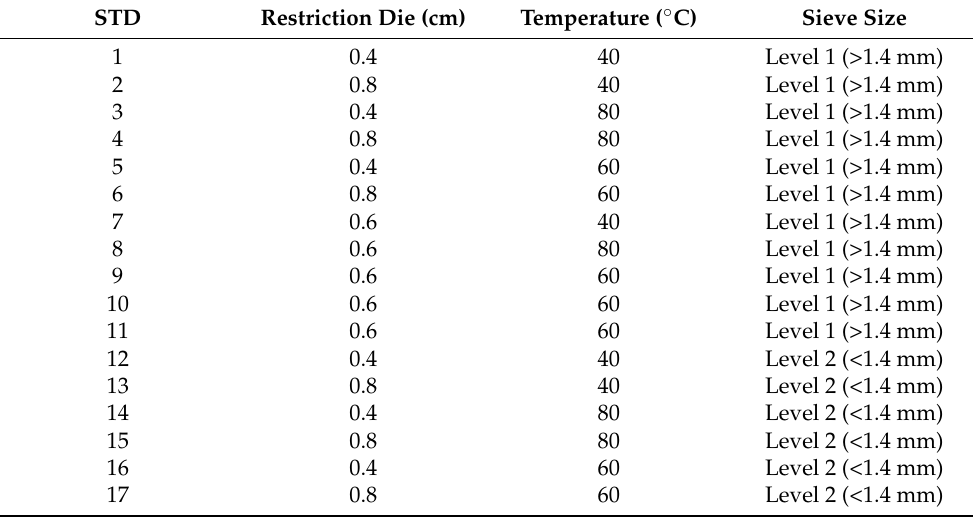
Table 1. Details of the standard runs (STD), restriction die range, temperature, and sieve size